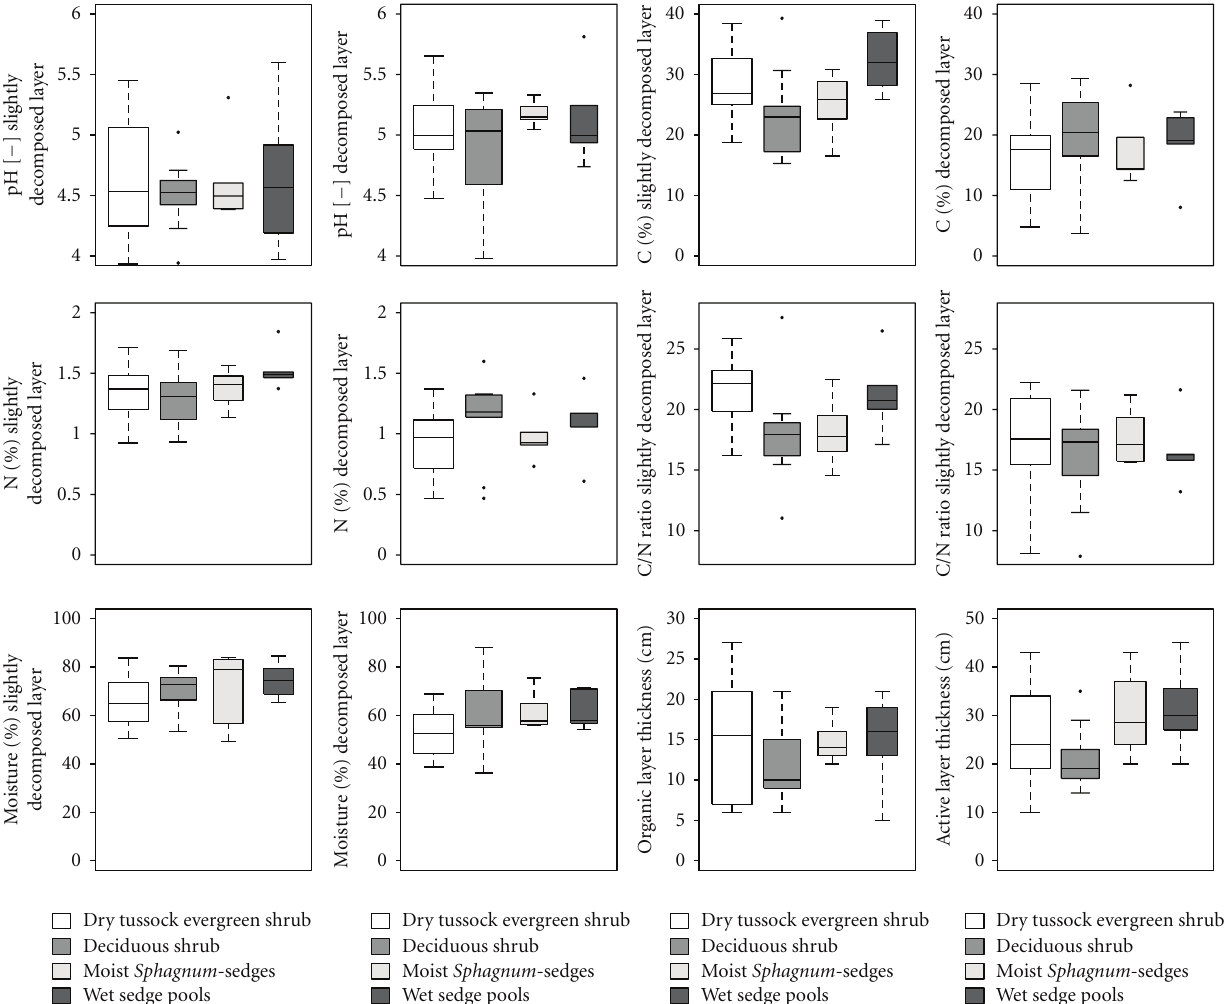
Figure 7: Boxplots of the predicted soil properties for the four vegetation